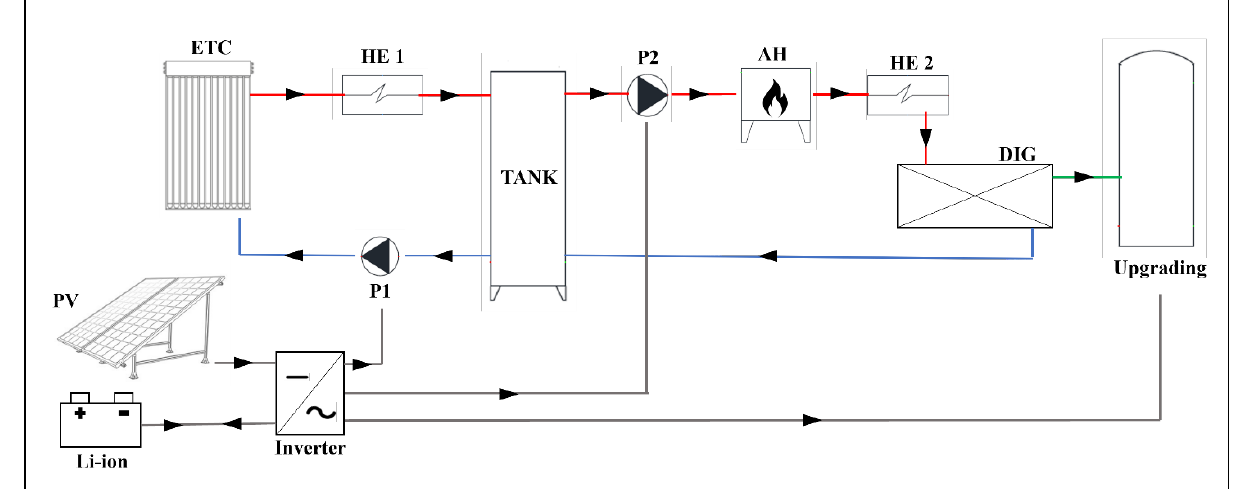
Figure 1. Layout of the plant .